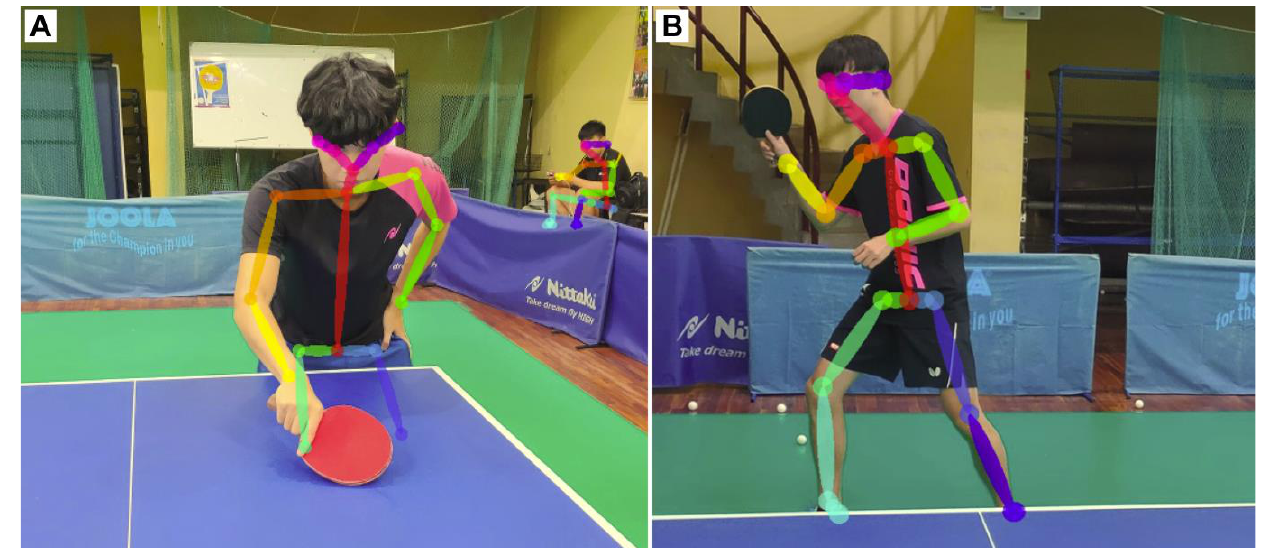
Figure 13. ( A ) Cut (after analysis). ( B ) Chop (after analysis). The cut and the chop after analysis.